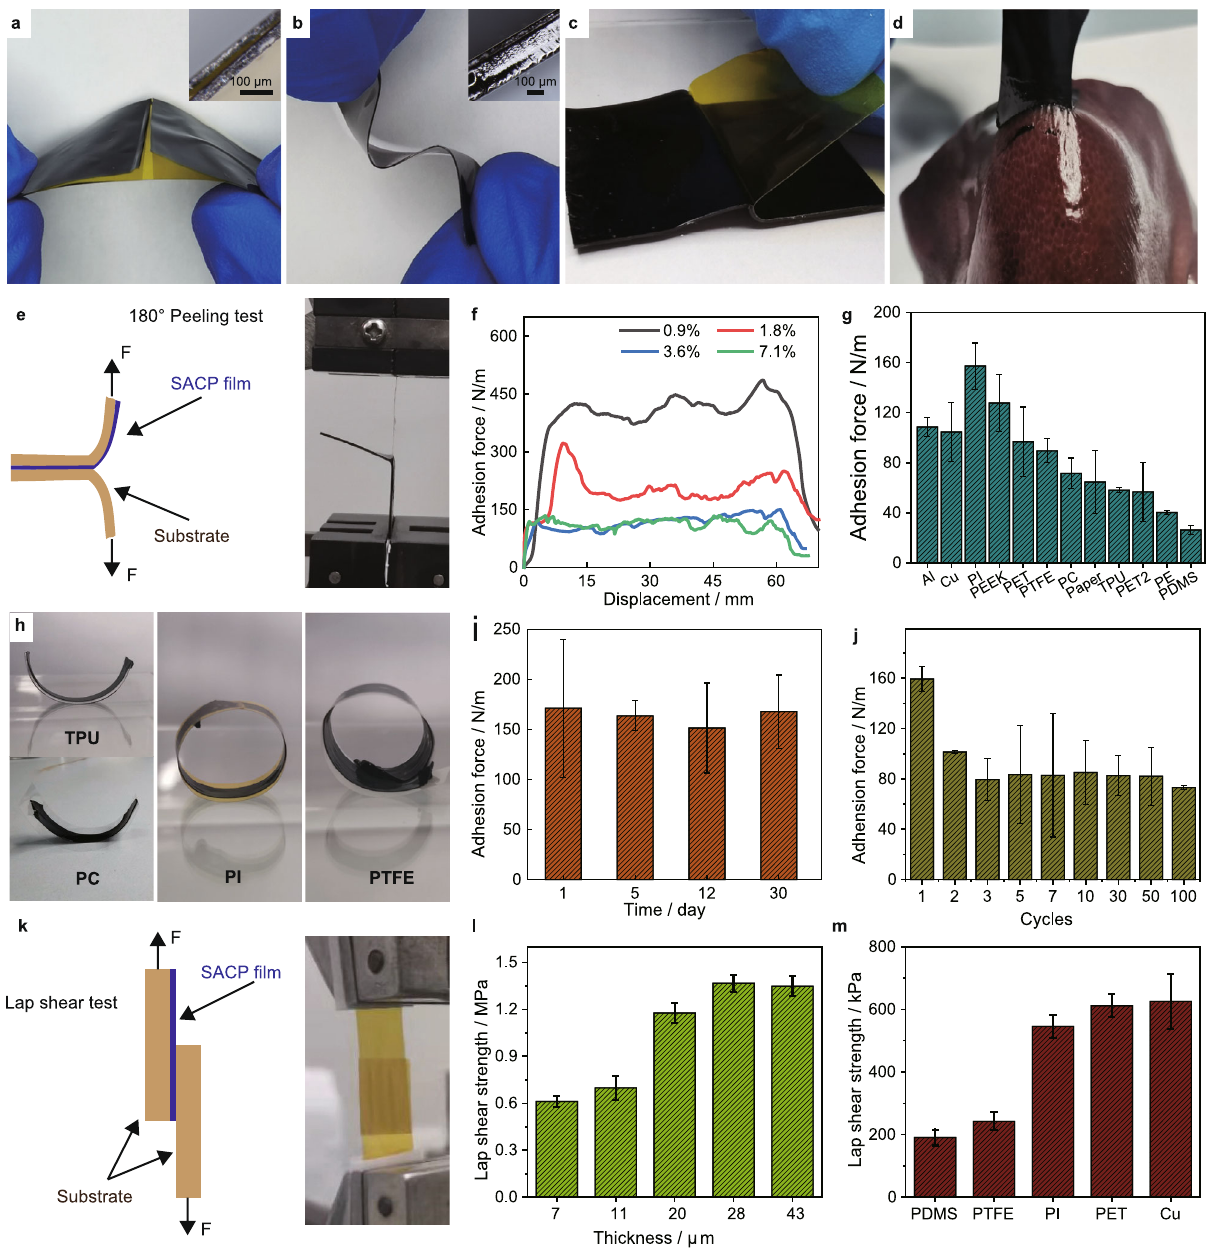
Fig. 3 Interface adhesion performance of SACP fi lms. a – b Images of pure PEDOT:PSS ( a ) and SACP ( b ) fi lms on PI substrate, insert: magni fi cations of adhesion interfaces. c Image of peeling off PI fi lm from the adhesive fi lm. d Image of adhesion between adhesion fi lm and liver of a pig (the liver surface was cleaned by absorbent paper). e Illustration (left) and image (right) of 180° peeling tests of SACP fi lms. f Measured peeling force per width of SACP fi lms with different PEDOT:PSS loadings on PI substrates. g Summary of adhesion strength of SACP fi lms on a wide variety of substrates. h Images of the bending state of substrates by releasing pre-stretched SACP fi lm-adhered substrates. i Adhesion stability of SACP fi lms after being stored in the constant temperature and humidity (temperature 30 °C, humidity 40%) for different days. j Adhesion strength of cyclic adhesion tests. k Schematic illustration (left) and image (right) of lap shear tests. l Lap shear strength of SACP fi lms with different thicknesses. m Summary of lap shear strength of SACP fi lms on different substrates. The error bars show the standard deviations from at least three